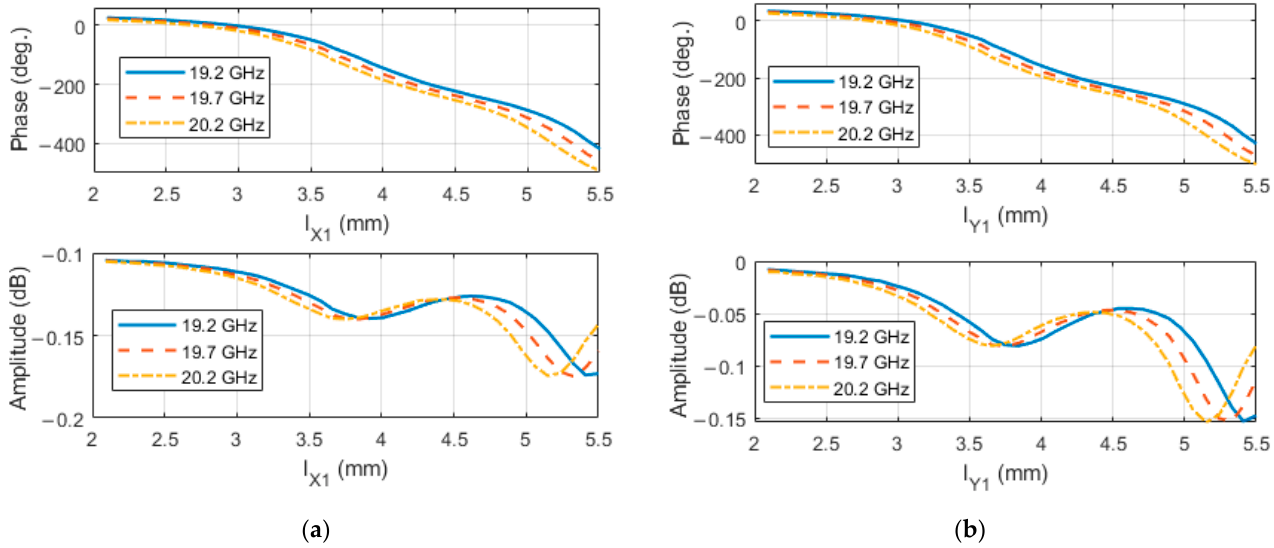
Figure 5. Phase and amplitude of the reflection coefficient associated with the ( a ) x component and ( b ) y component of the incident field, at several frequencies in the 20 GHz band.